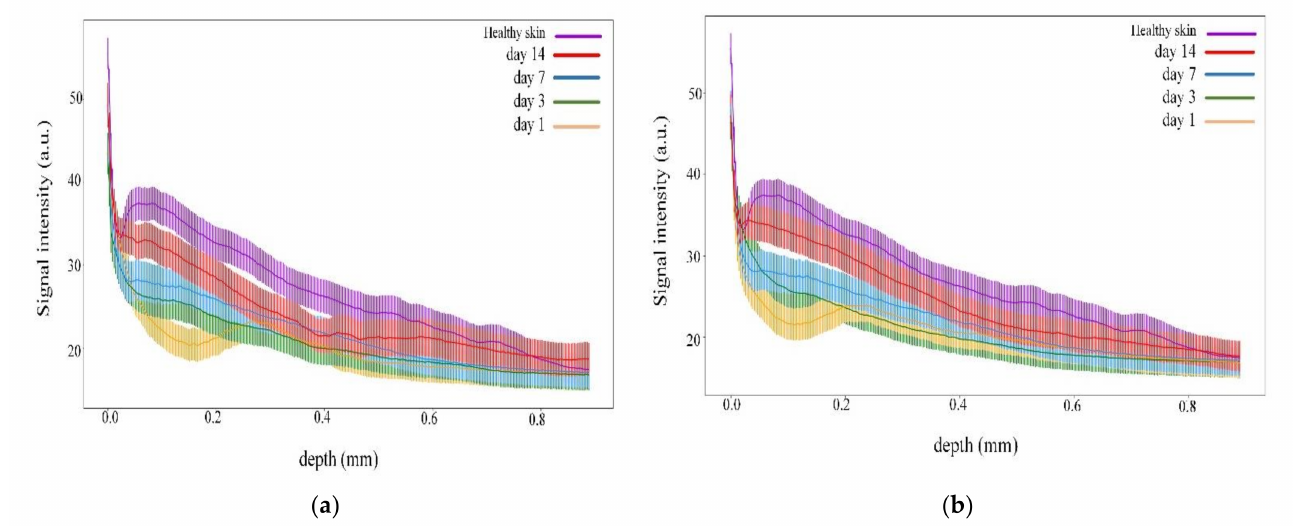
Figure 11. ( a ) Visual observation and ( b ) the corresponding B-scans for the LDPDT-MB 4 J/cm 2 group.